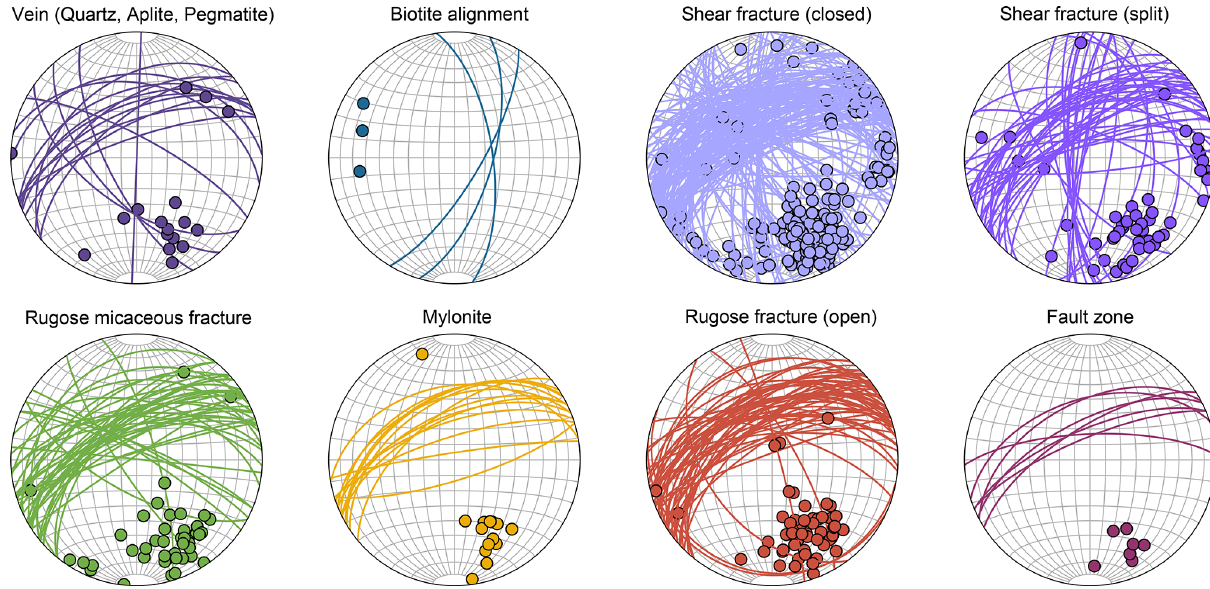
Figure 7. Mapped geological structures by type. The upper row shows the orientation of structures that are mainly “closed” (based on visual examination of the cores). The lower row shows the orientations of structures with higher shear strain and can be perceived as “open”. Note the structures shown in the lower row are almost exclusively oriented